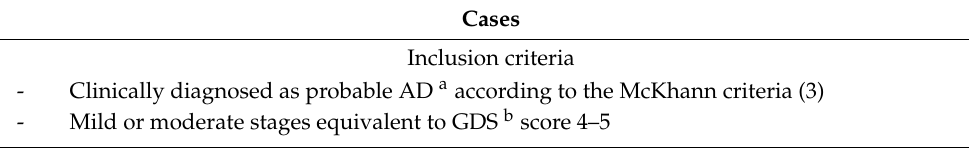
Table 5. Cutoff study: inclusion and exclusion criteria for cases and